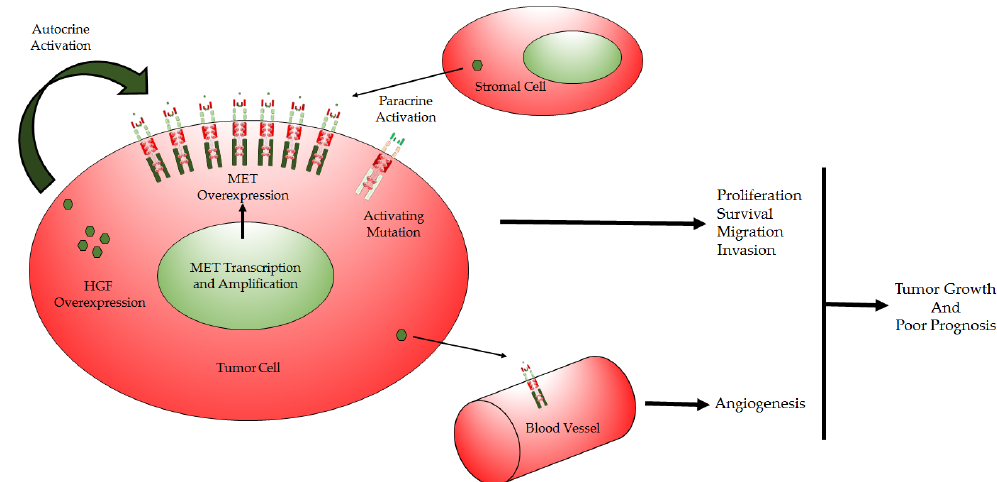
Figure 3. Modes of deregulation of HGF/MET in cancer: (1) Autocrine and paracrine overexpression of HGF, (2) Amplification of MET gene leading to MET protein overexpression, (3) An activating mutation resulting in a constitutively active protein product, (4) HGF overexpression by tumor cells activating MET in the tumor microenvironment.